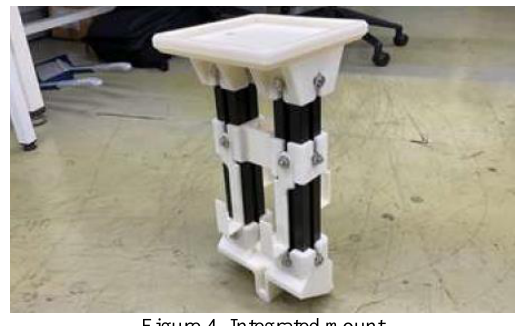
Figure 4. Integrated mount